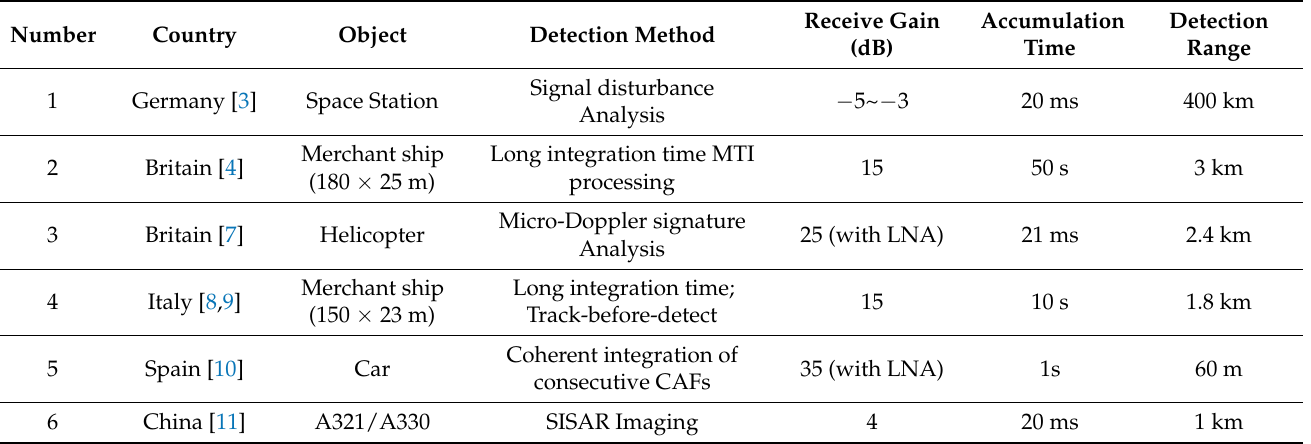
Table 1. Experimental results of GNSS-based passive radar. (LNA: low noise amplifier; MTI: moving target indicator; CAF: cross ambiguity function; SISAR: shadow inverse synthetic aperture